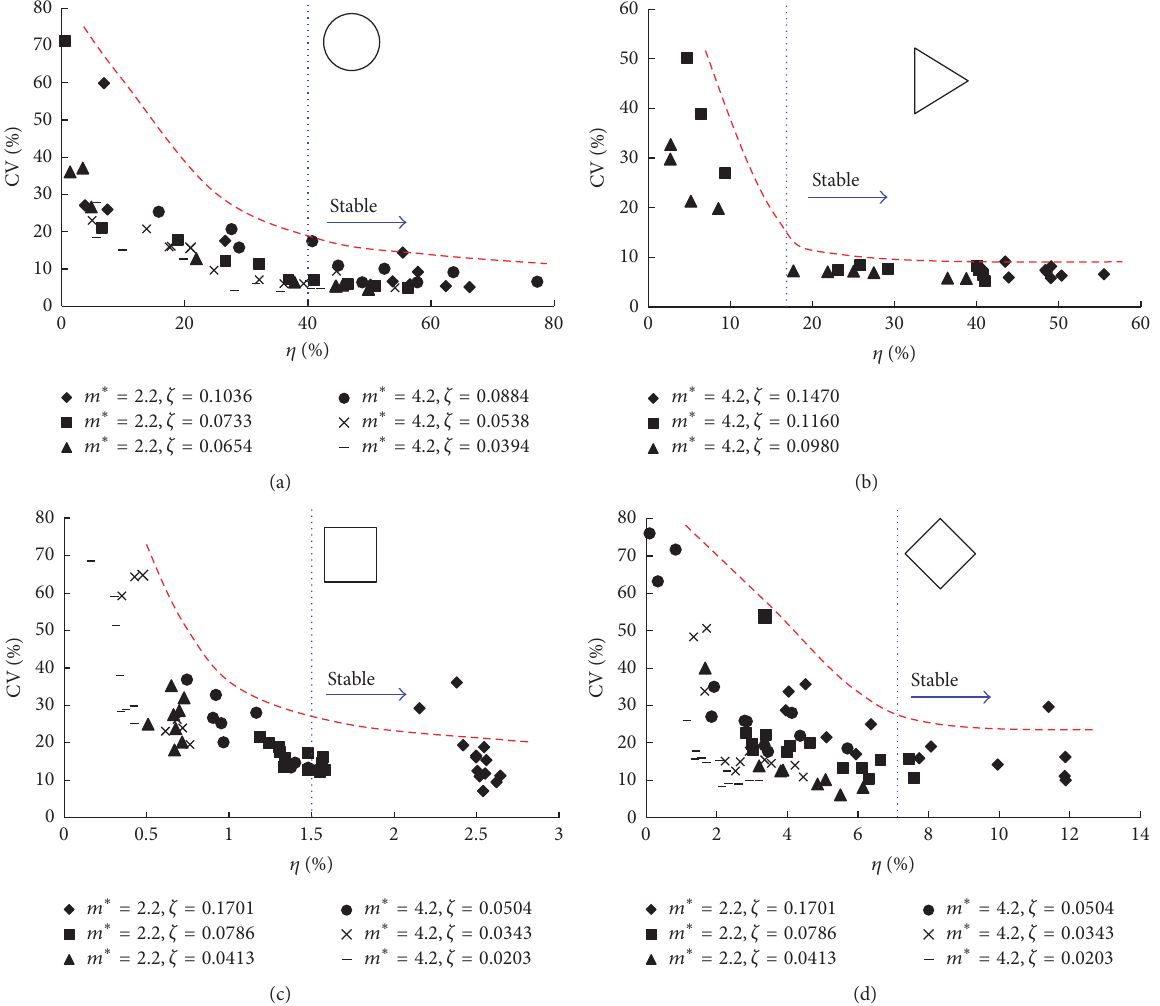
Figure 15: Variations of the variation coefficients of amplitude CV with the energy transfer ratios 𝜂 . (a) Circular cylinders; (b) regular triangle prisms; (c) right square prisms; (d) diamond